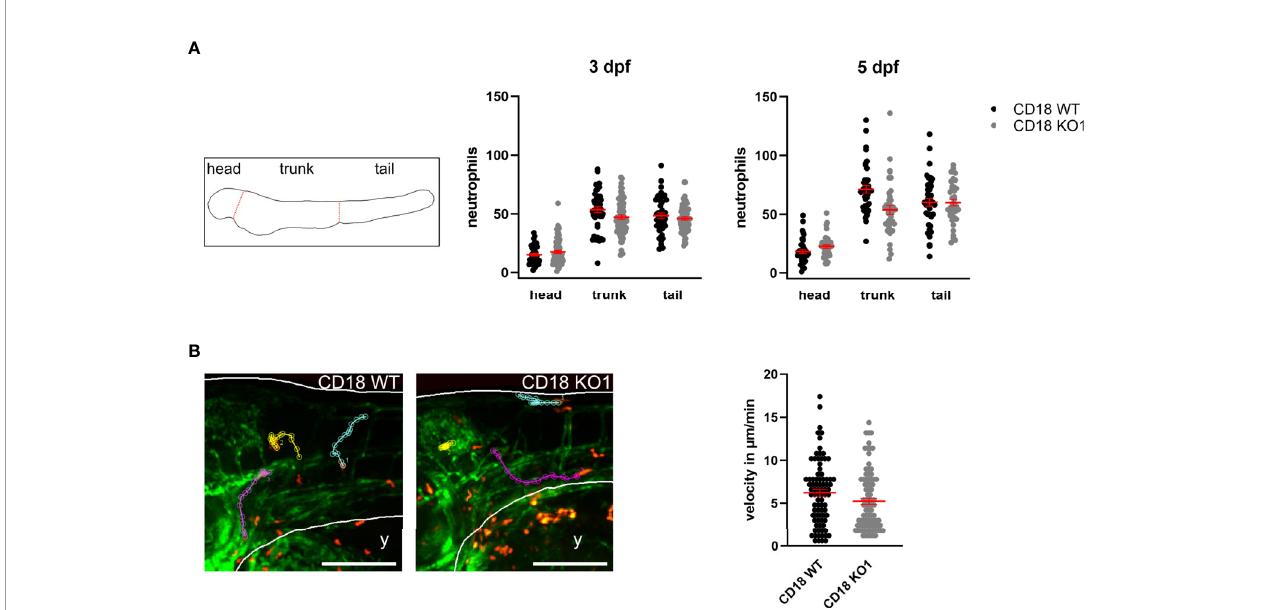
FIGURE 2 | Analysis of neutrophil count and random migration at steady state. (A) Left: Schematic of zebra fi sh larvae for analyzing neutrophil distribution in head, trunk, and tail. Middle and right: Distribution of neutrophils in CD18 WT and CD18 KO1 zebra fi sh larvae at 3 dpf and 5 dpf. Mean ± sem of ≥ 44 individual larvae of ≥ 3 independent experiments. (B) Left: Exemplary maximum intensity projections of randomly migrating neutrophils in the head area of CD18 WT (left) and CD18 KO1 (right) zebra fi sh larvae at 5 dpf. Endothelial cells are shown in green. Neutrophils are shown in red. Y indicates yolk. Three representative migration tracks of neutrophils within 15 min are highlighted. Scale bars represent 200 µm. Right: Mean migration velocity of individual neutrophils. Mean ± sem of ≥ 84 individual neutrophils of ≥ 5 independent experiments. Unpaired